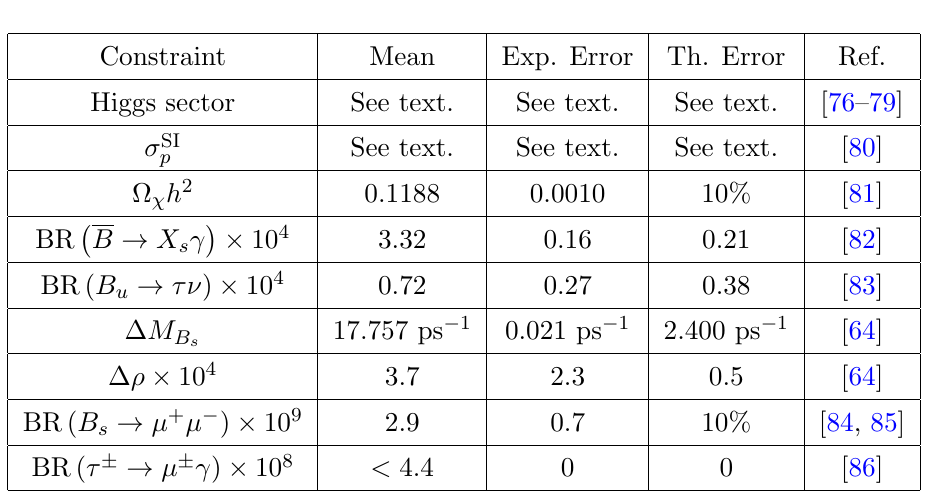
Figure 8. Main loops contributing to (cid:14) ( g to one of the charged legs is implicit. We have explicitly written the scalar component of the supermultiplet E as ~ E .